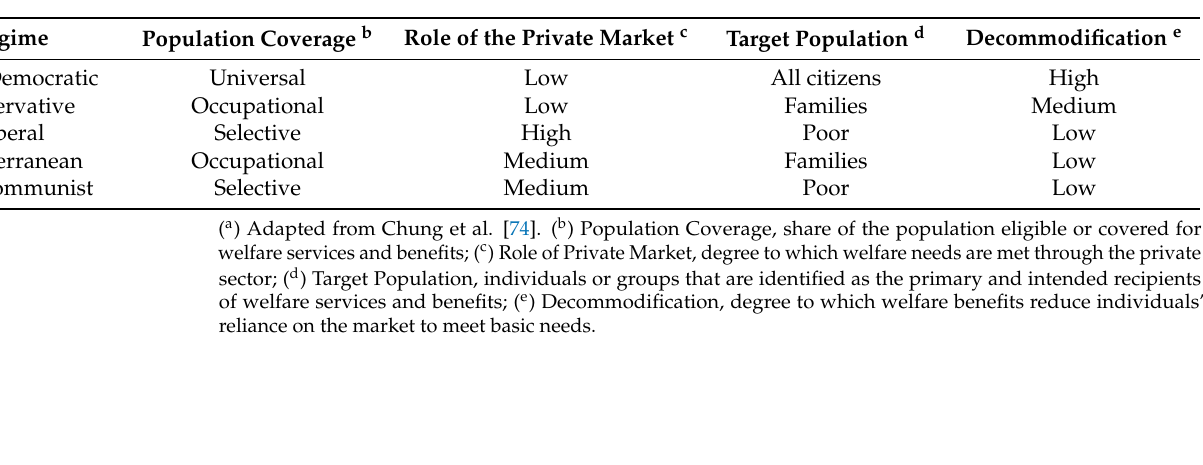
Table A1. General features of welfare state regimes a